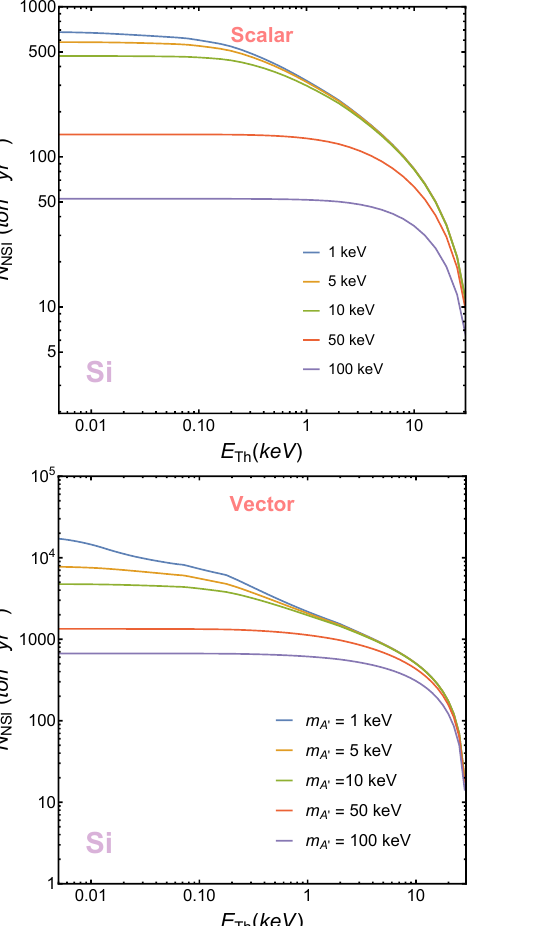
. The Th upto 30 keV. The coupling Th = g = 1 . 5 × 10 − 7 ν e